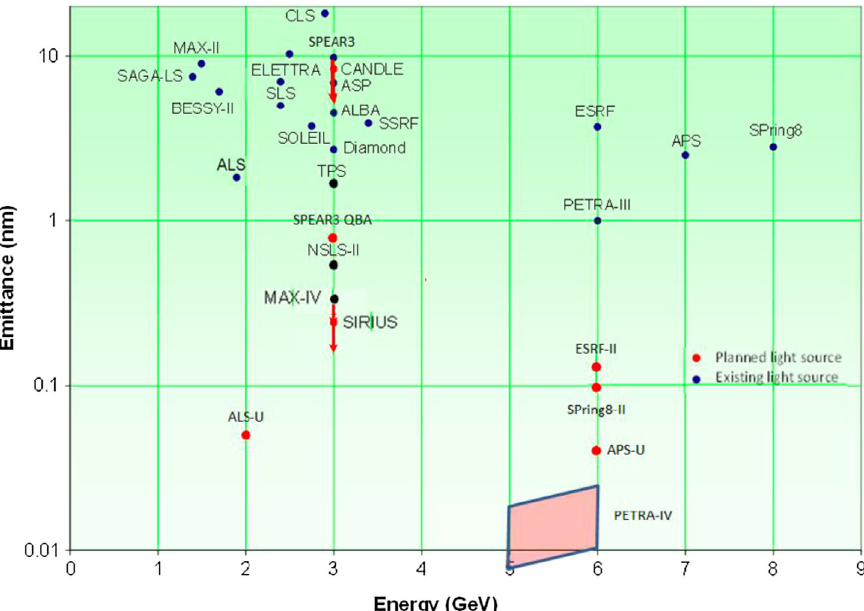
FIG. 5. Horizontal beam emittances at existing and planned world advanced light sources [28] Red ¼ planned Blue ¼ existing (From Argonne National Laboratory, managed and operated by UChicago Argonne, LLC, for the US Department of Energy under Contract No. DE-AC02-06CH11357).